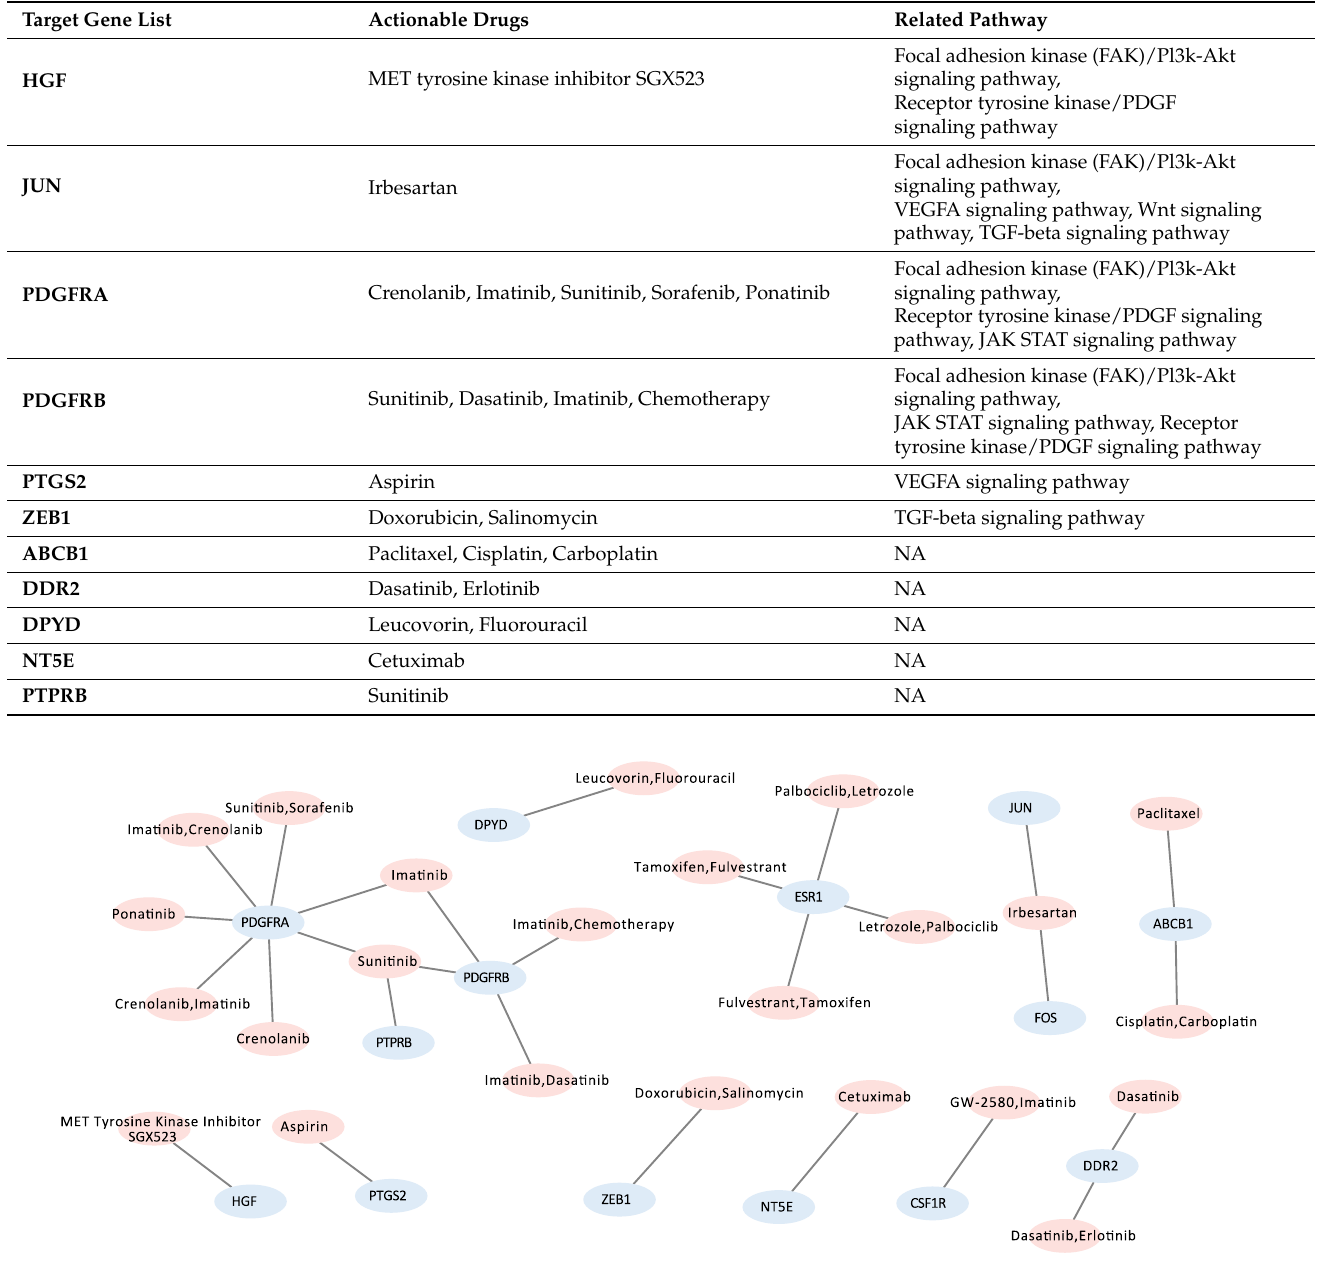
Figure 3. Visualization for gene–drug network analysis. Gene–drug network analysis was performed using the selected 1325 genes and the CIViC drug database via Cytoscape. Genes are represented in blue and drugs are represented in pink. Table 2. List of 14 target candidate genes via gene-drugs network based on the CIViC database.